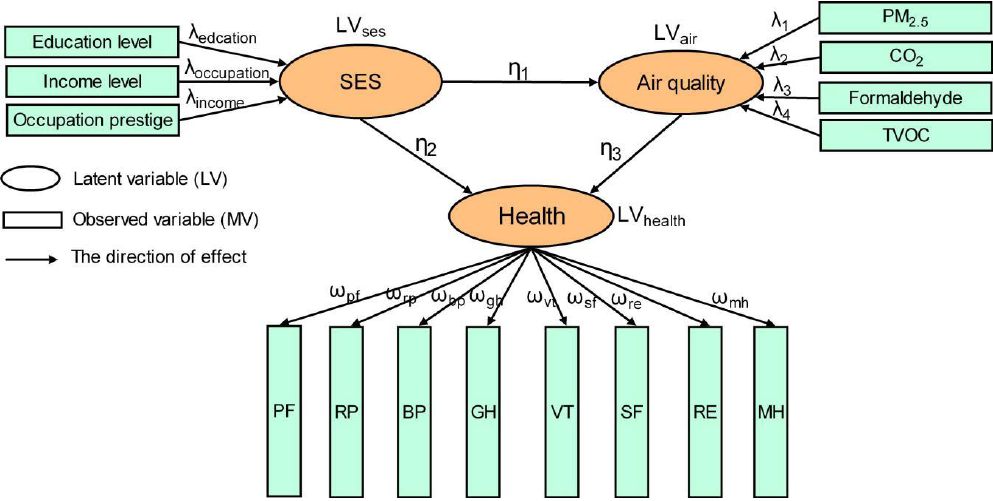
Figure 2. The theoretical model used for characterizing relations between indoor air quality, socioeconomic status and health. SES — socioeconomic status; Air quality-indoor air quality; PF — physical functioning; RP — role physical; BP-bodily pain; GH — general health; VT — vitality; SF — social functioning; RE — role emotional; MH — mental health.